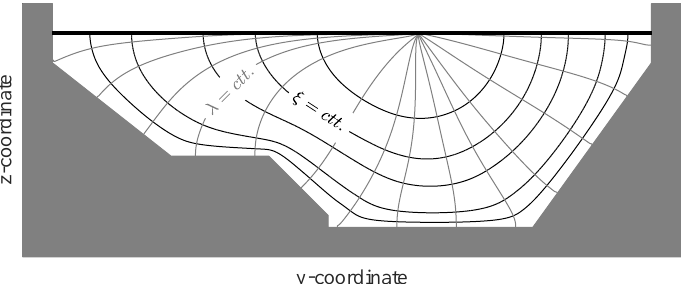
Figure 1. Diagram of orthogonal ray ( λ ) and isovel ( ξ )